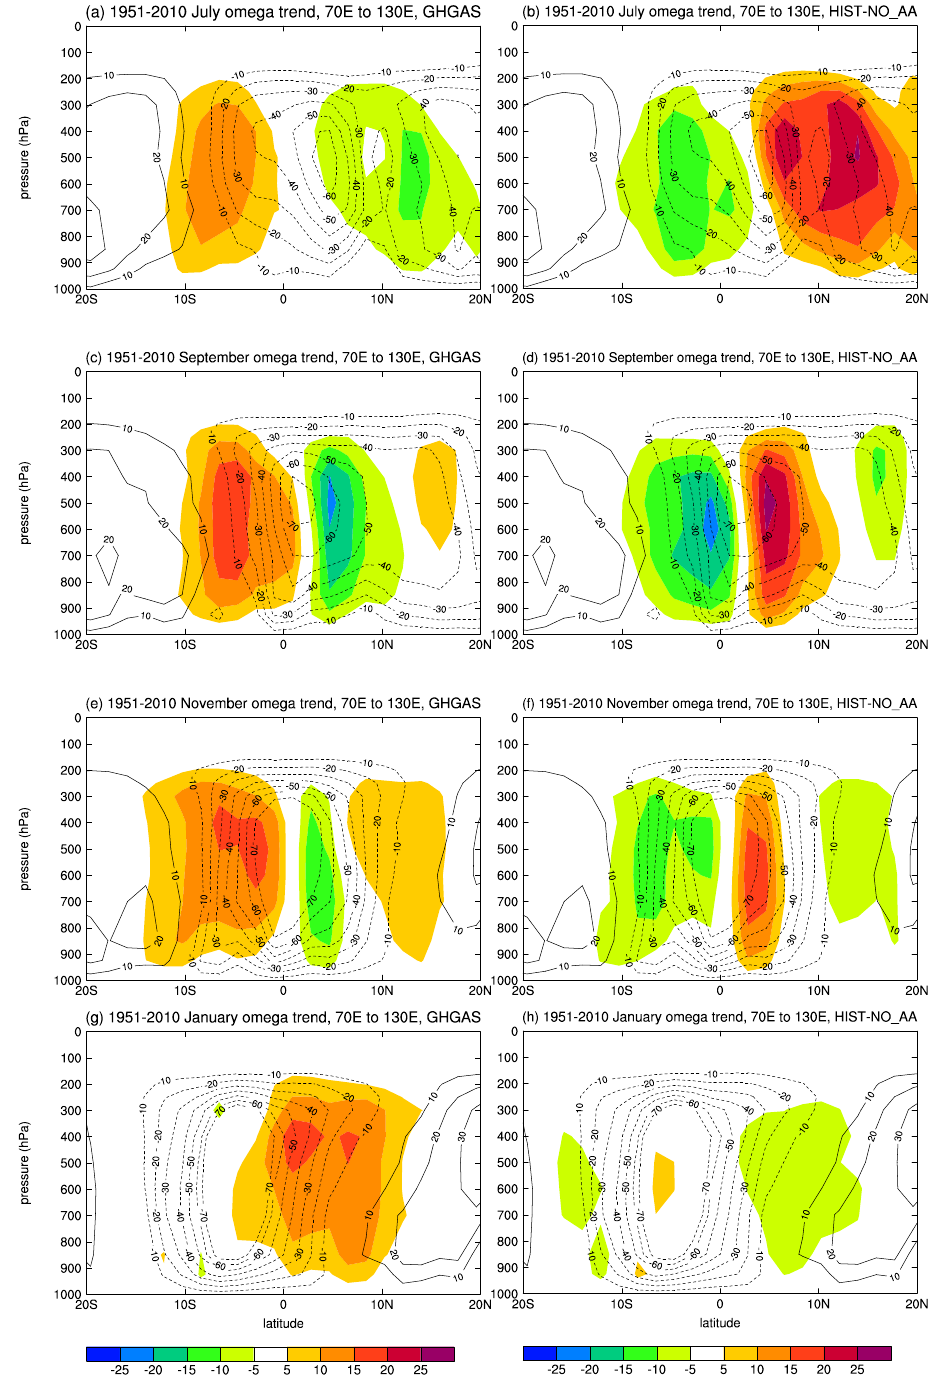
Fig. 20. 1951–2010 ensemble-mean trends of vertical pressure velocity, zonally averaged between 70 ◦ E to 130 ◦ E (shading, hPaday − 1 century − 1 ) for (a, b) July, (c, d) September, (e, f) November and (g, h) January, from GHGAS (left column) and HIST mi- nus NO AA (right column). For each month, the black contours show the mean vertical velocity field (averaged over 1970–1989 from the HIST ensemble); negative contours (denoting upward motion) are dashed. Contour interval is 10hPaday − 1 , with the zero contour